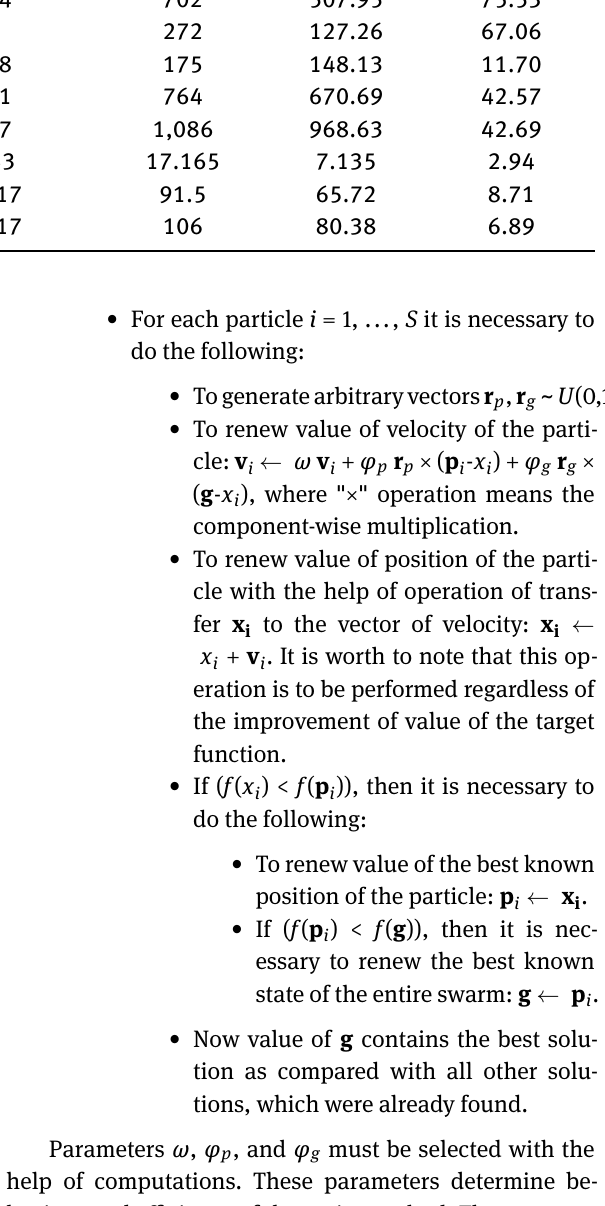
Table 1: Range of materials and compressive strength in the database of the fly-ash high-performance concretes Materials Unit of Minimum Maximum Average Standard meas-t Ordinary Portland